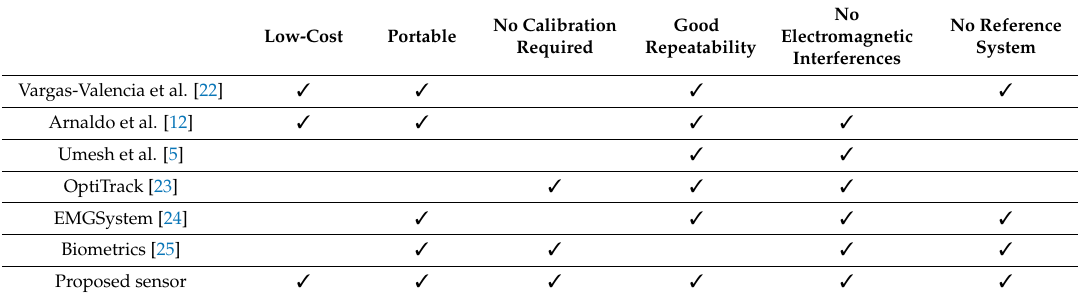
Table 3. Comparison between sensors for joint angle